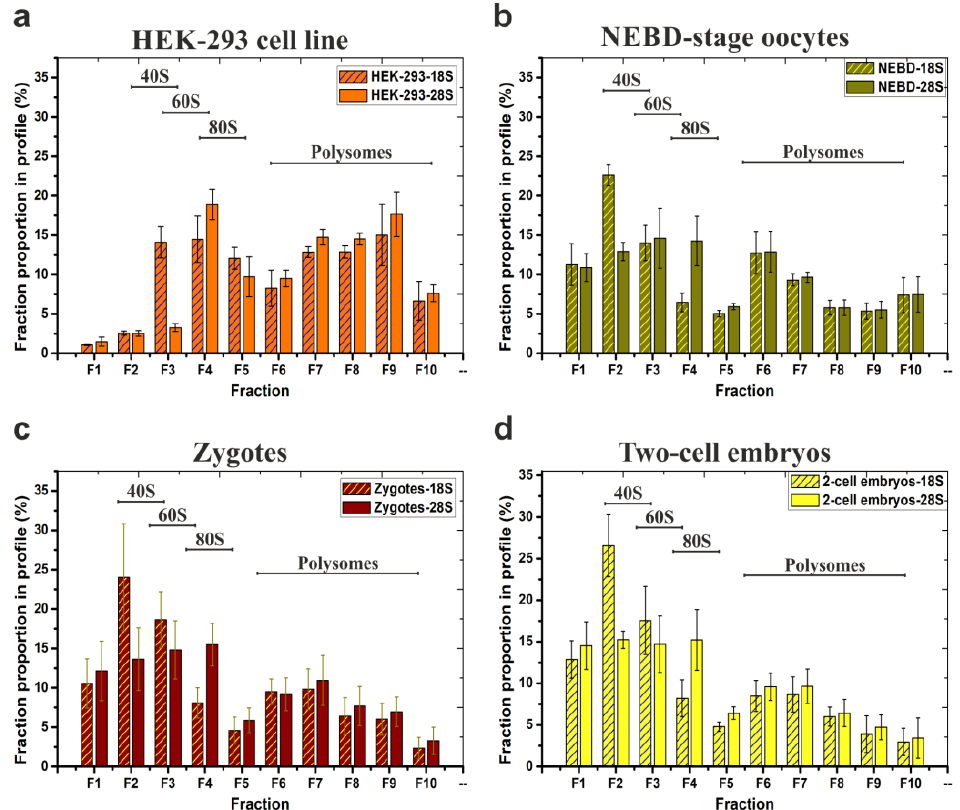
Figure 3. Typical distribution and abundance of ribosome- and polysome- ribonucleoprotein complexes in polysome profiles as determined by qRT-PCR analysis. Data are derived from four biological replicates of: ( a ) HEK-293 cell line (note, the same samples were analysed in Figure 2c); ( b ) 200 mouse NEBD-stage oocytes used for RNA-seq; ( c ) 200 zygotes and ( d ) 200 two-cell embryos. 18S and 28S contents in each fraction are displayed as percentages of the respective fraction compared to the whole polysome profile; error bars indicate ±SD of biological replicates. Note, qRT-PCR-based visualization of individual replicate/source polysome profiles are included in Figure S4.